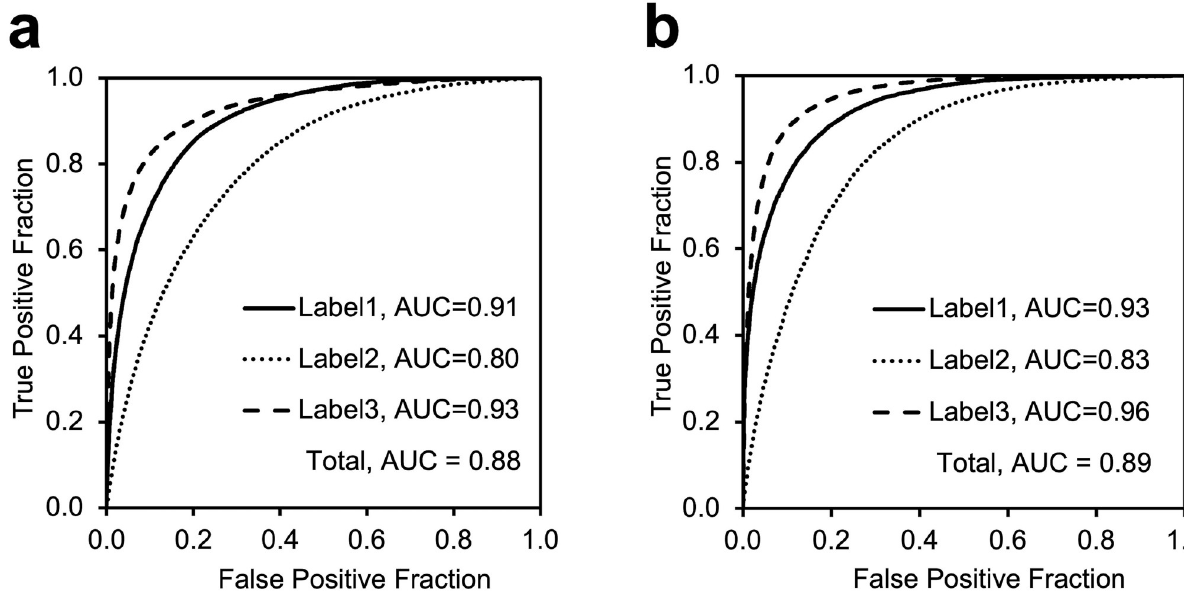
Fig 3. Receiver operating characteristic curves for the learned model developed in this study. (a: Stationary type, b: Portable type).